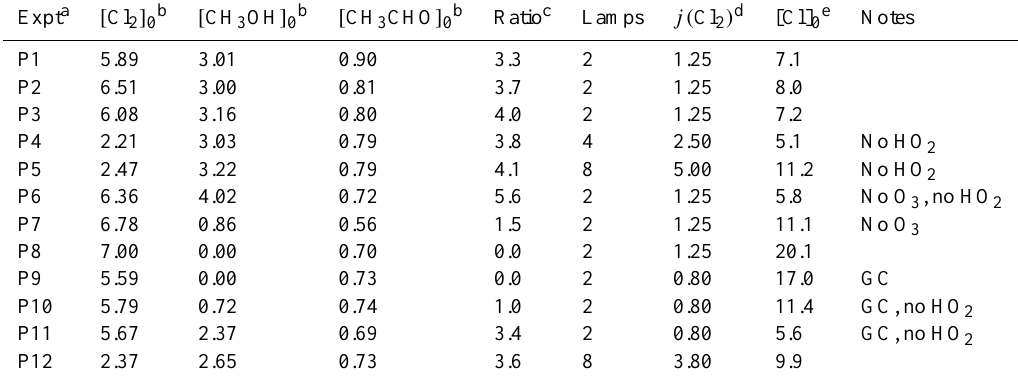
Table 1. Experimental conditions and for the investigation into CH 3 C(O)O 2 + HO 2 (Reaction R5) conducted in a synthetic air mixture at 1000mbar and 293K. Lower j (Cl 2 ) for experiments P9–P12 due to degradation of lamps over time in between first P1–P8 experiments. Expt a [ Cl 2 ] 0b [ CH 3 OH ] 0b [ CH 3 CHO ] 0b Ratio c Lamps j( Cl 2 ) d